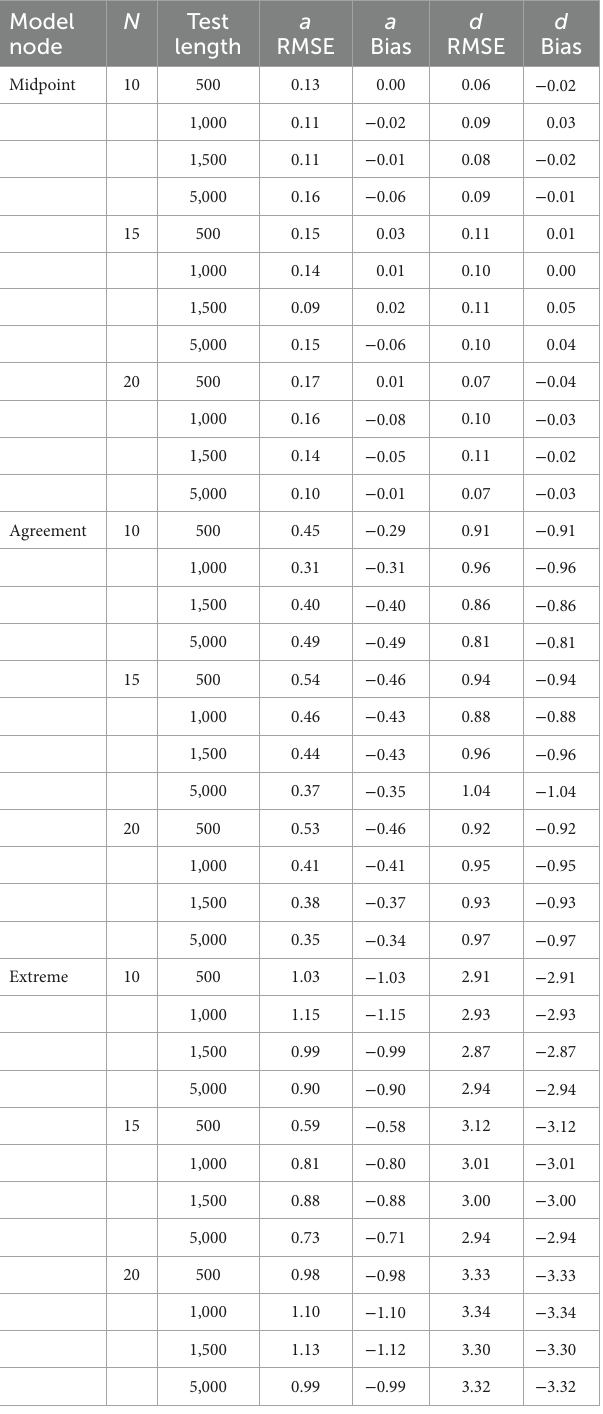
TABLE 3 Parameter recovery statistics for the IRTree MPP model fitted to IRTree MPP model